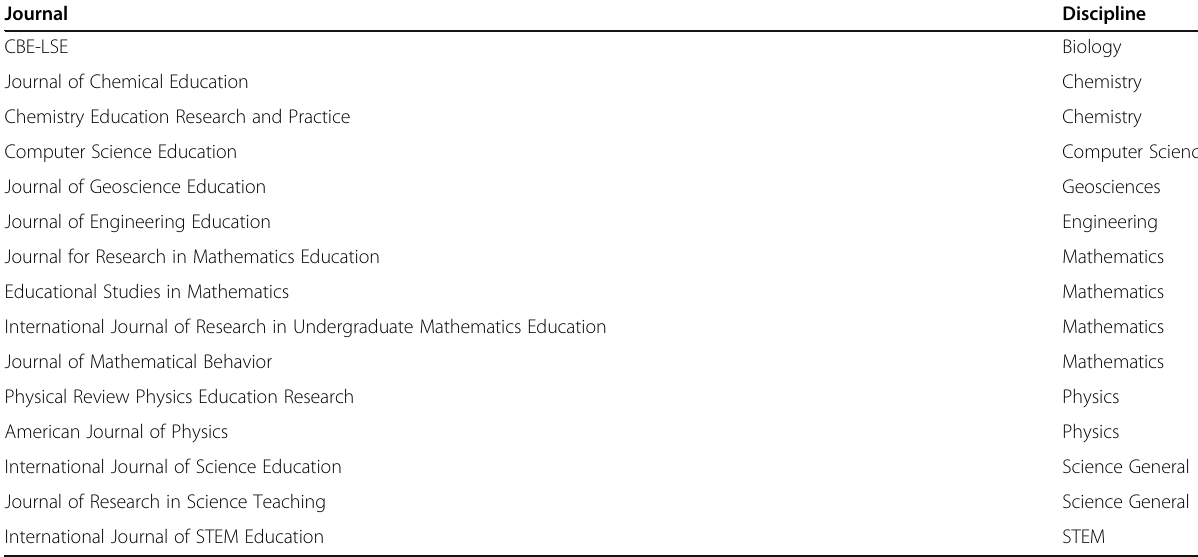
Table 1 STEM-DBER disciplinary journals searched for the fourth corpus of articles